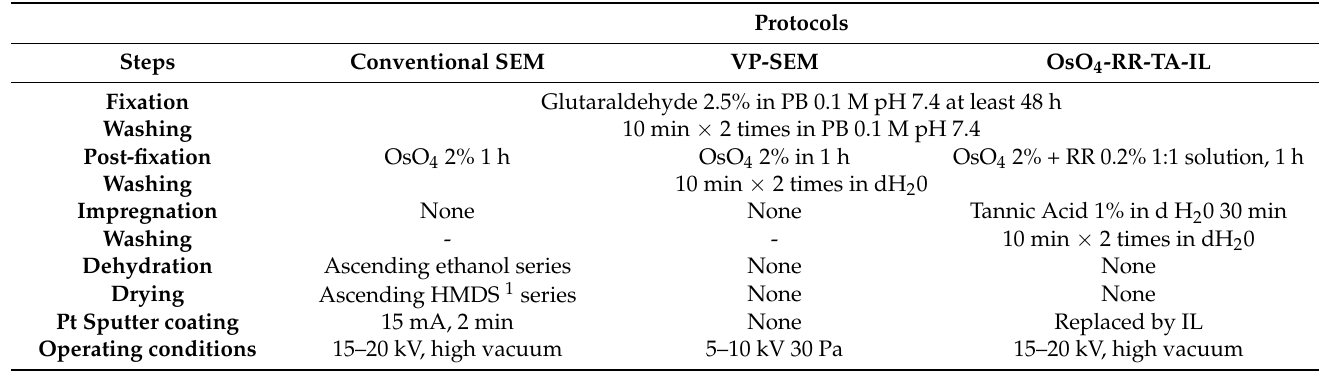
Table 2. S. mutans processing procedures and operating conditions from [50].